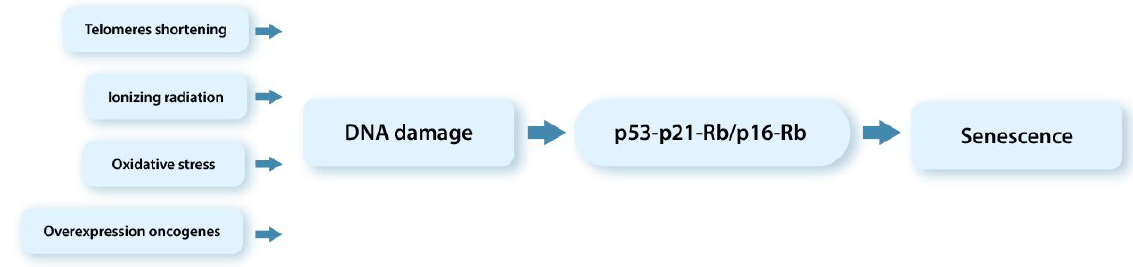
Figure 3. Schematic representation of cellular aging.